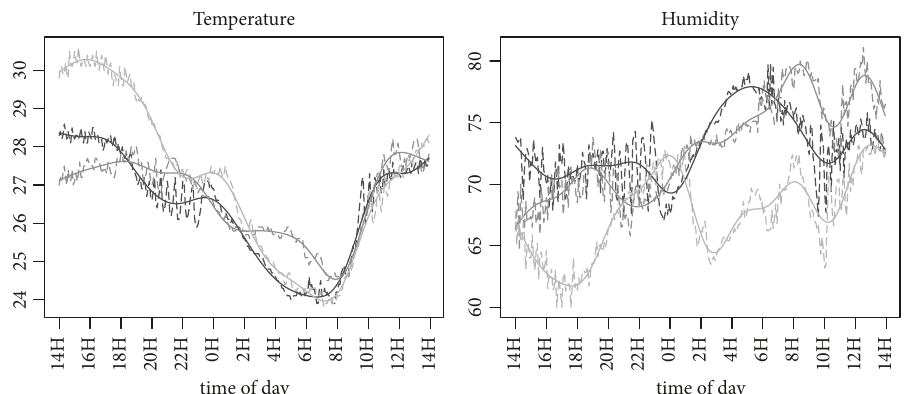
Figure 1: Temperature ( ∘ C) and humidity (%) observed profiles (dashed) for three randomly selected days and the corresponding smoothed ones (solid); the x-axis begins at 14H (2PM).